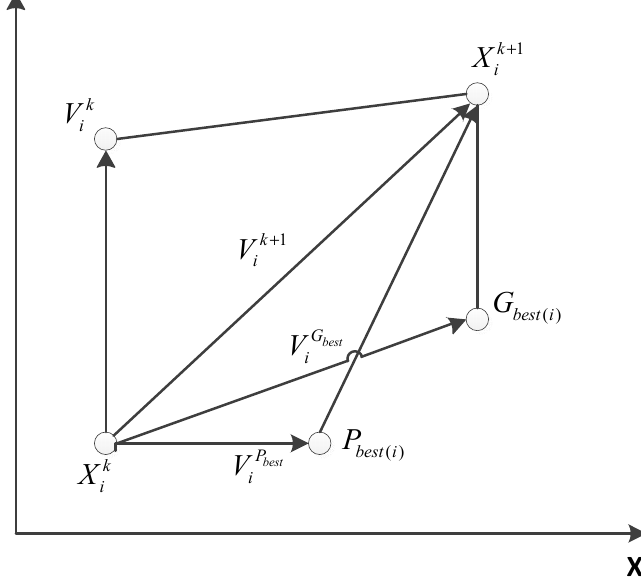
Figure 3. The modification of a searching points by Particle Swarm Optimization (PSO) [23].